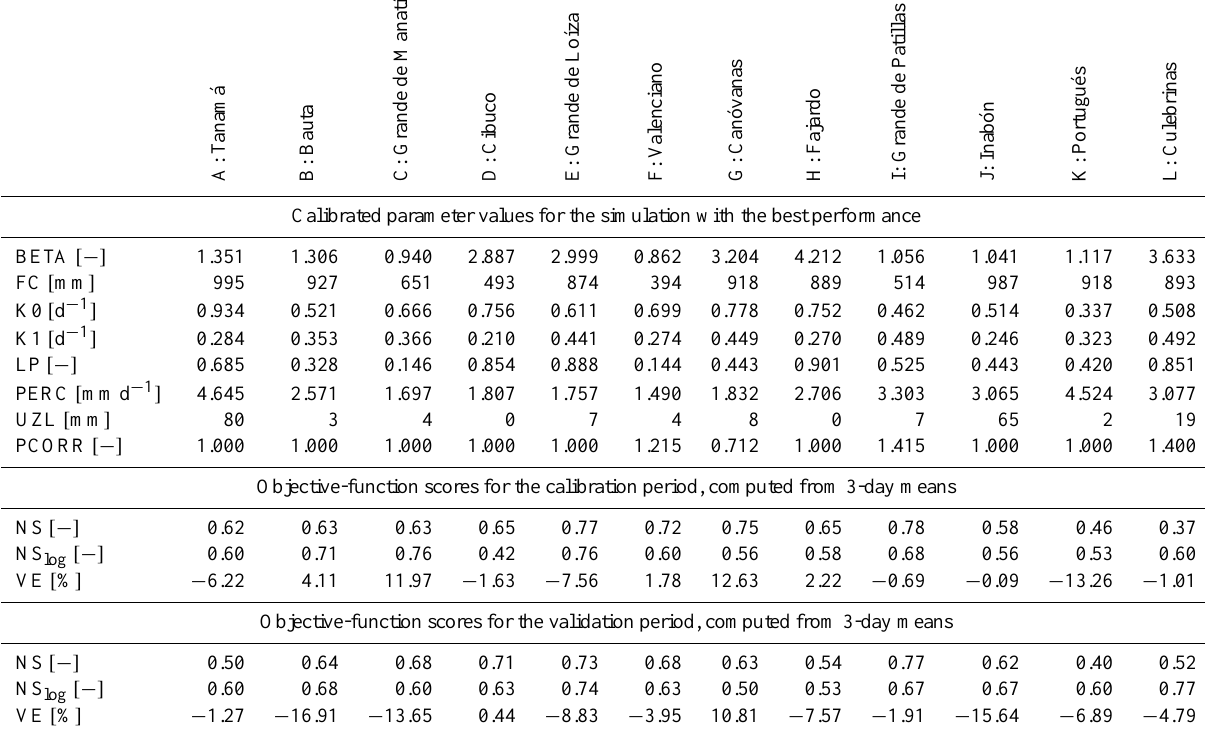
Table 4. Calibrated parameter values for the single best simulation by the HBV-light model, and objective-function scores (mean of the 30 best simulations) for the calibration and validation periods, computed from 3-day means. The PCORR parameter was only calibrated for four